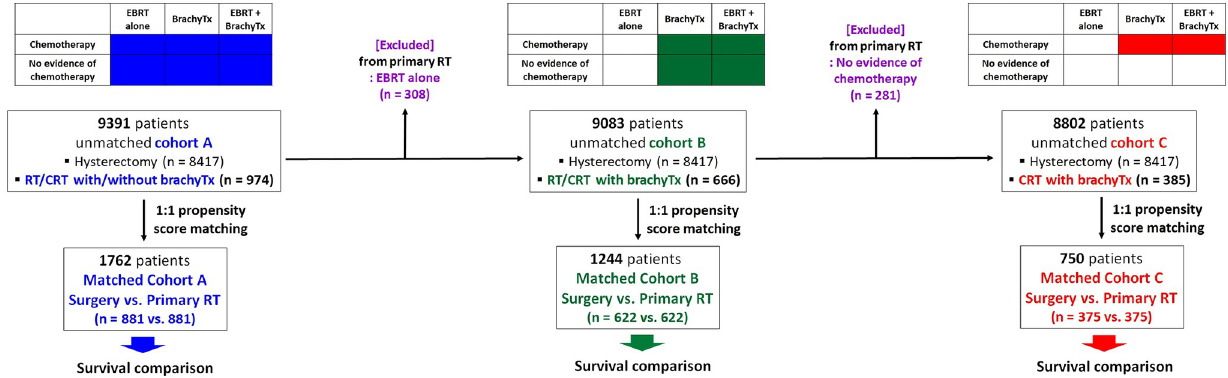
Fig 1. Definition of cohorts A, B, and C and composition of patient subsets before and after propensity score matching. EBRT, external beam radiotherapy; brachyTx, brachytherapy; RT, radiotherapy; CRT, chemoradiotherapy.